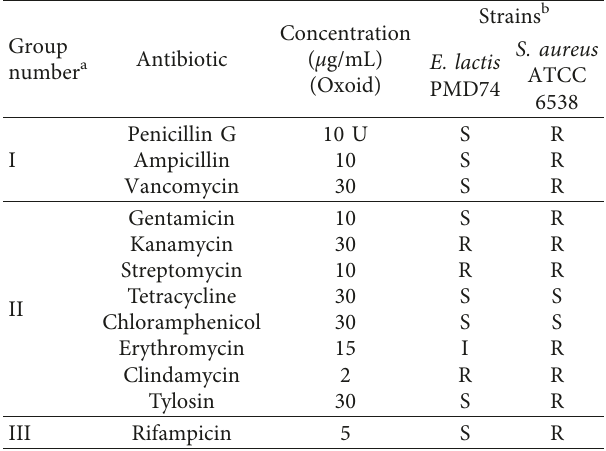
Table 3: Antibiotic susceptibility of E. lactis PMD74 and S. aureus ATCC